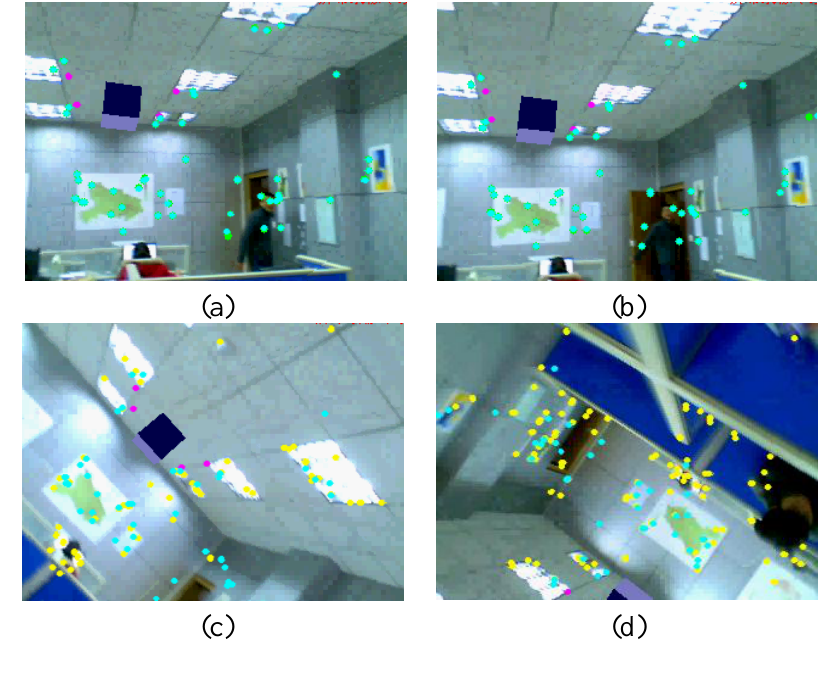
Figure 5 . Results of the second indoor experiment.